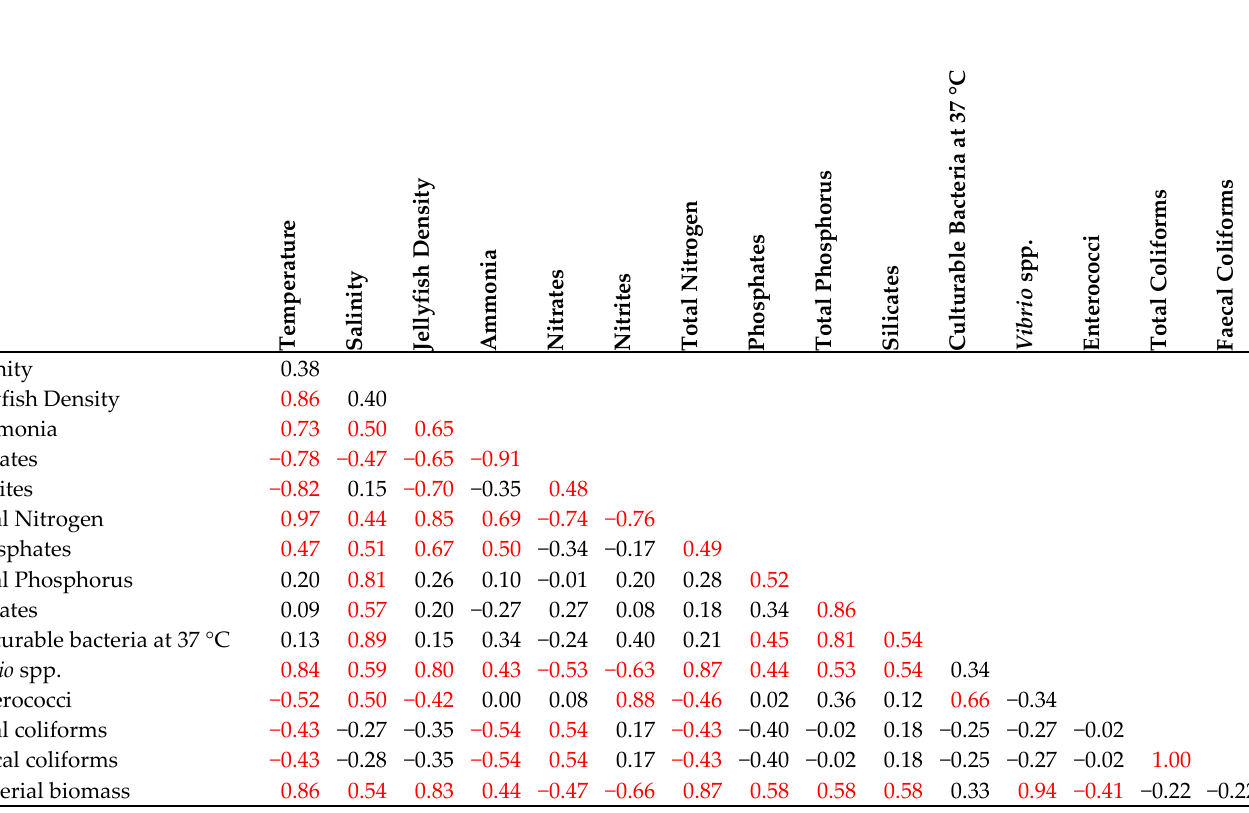
Table 4. Results of the permutational analyses (PERMANOVA) on bacterial biomass, Vibrio spp., culturable bacteria at 37 °C, faecal enterococci, and faecal and total coliforms in the W and E zones (Z) among sampling times (T). Abbreviations: Res — residual; Tot — total; df — degrees of freedom; MS — mean squares; Pseudo-F — F critic; P — permutational level of probability. *** p < 0.001; ns —